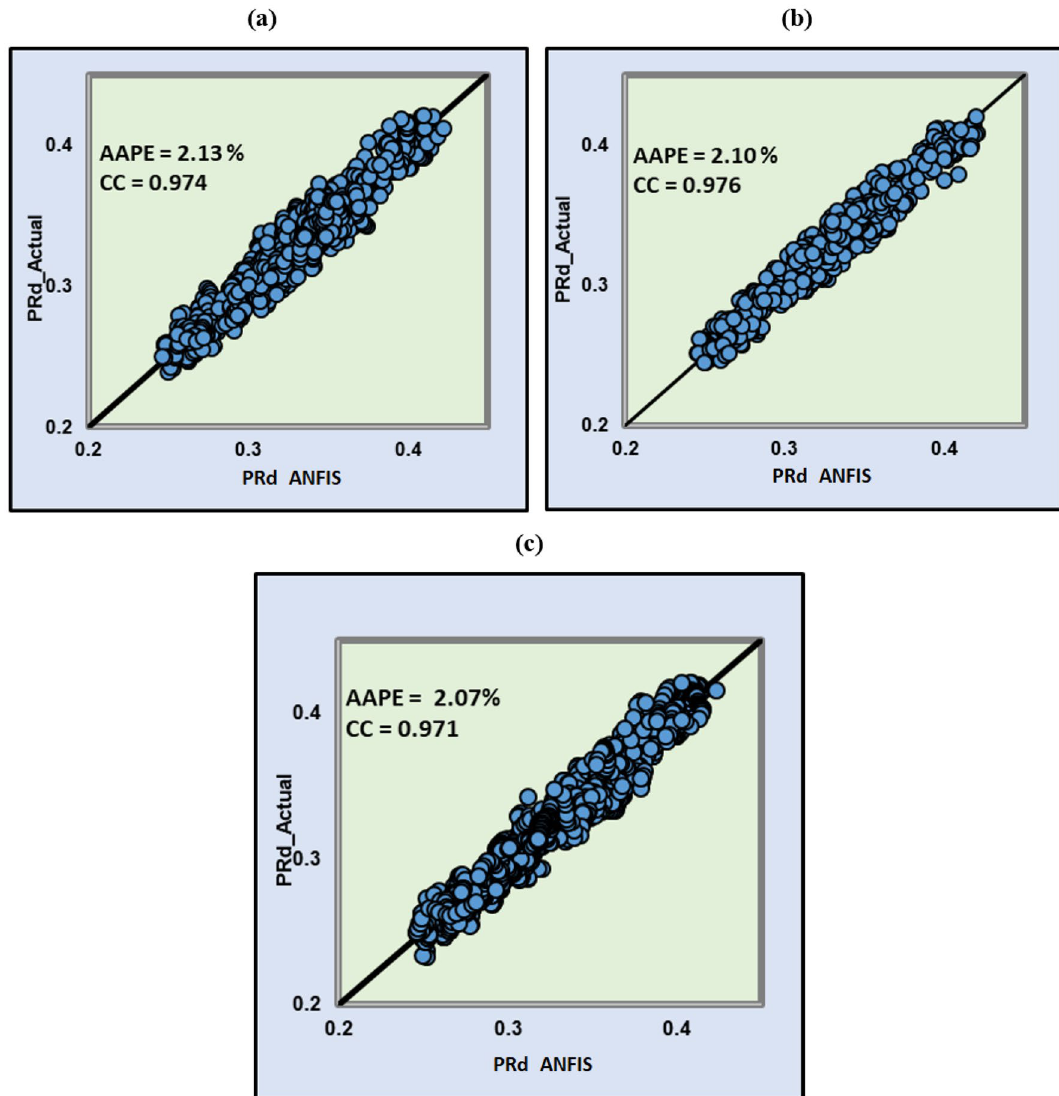
Figure 12. Actual and ANFIS predicted Poisson’s ratio for ( a ) training, ( b ) testing and ( c )